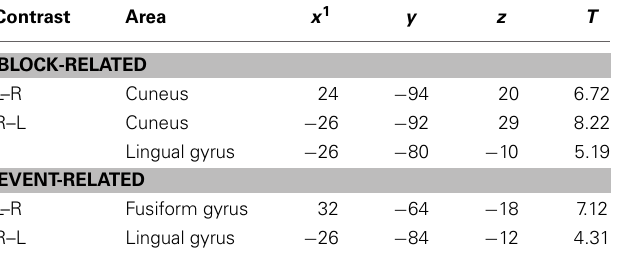
Table 1 | MNI coordinates (mm) of regions identified in whole-brain contrasts, significant at p < 0 . 05 corrected.